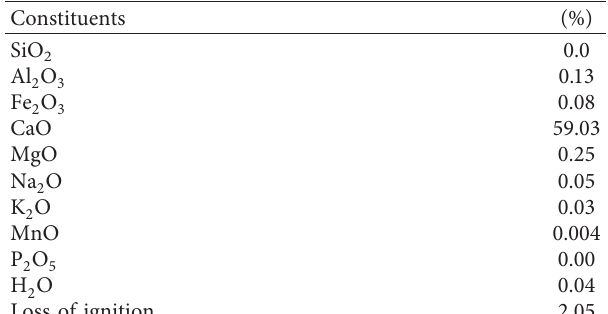
Table 2: Properties of used expansive clay soil [20].